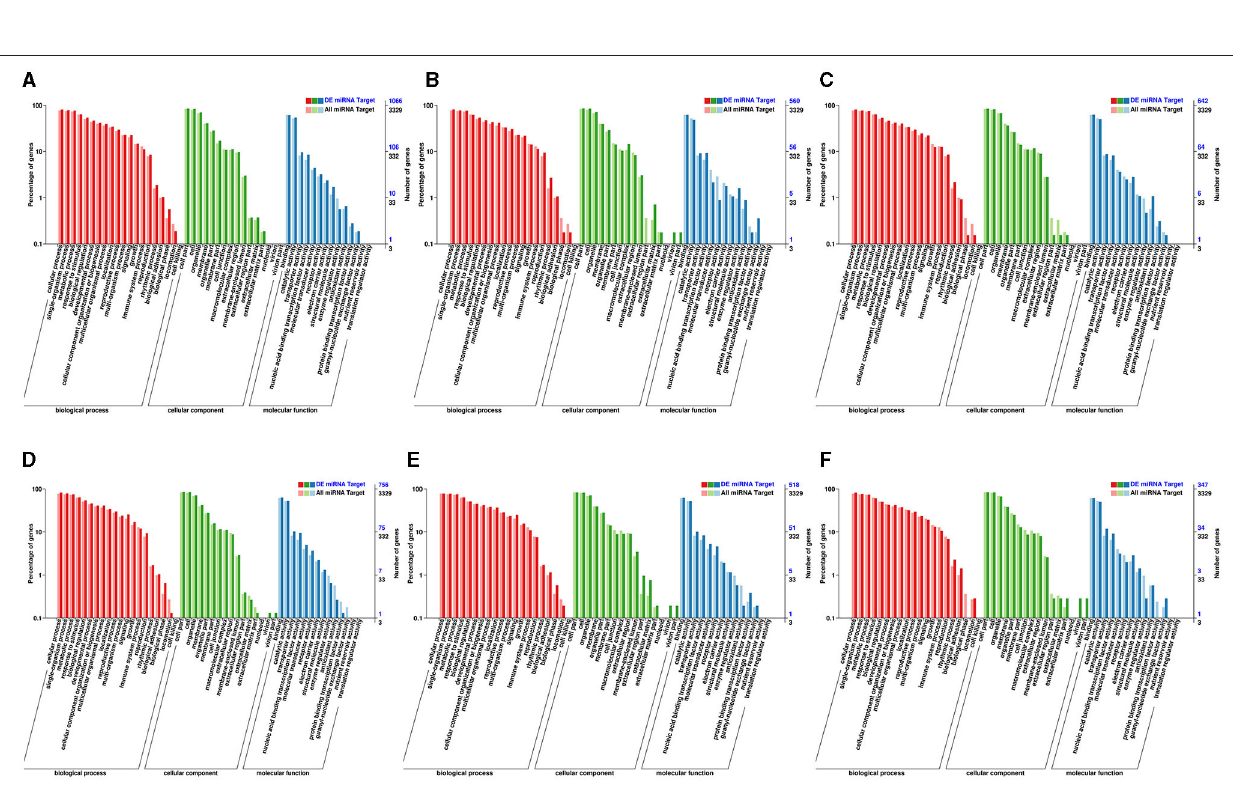
Frontiers in Ecology and Evolution |